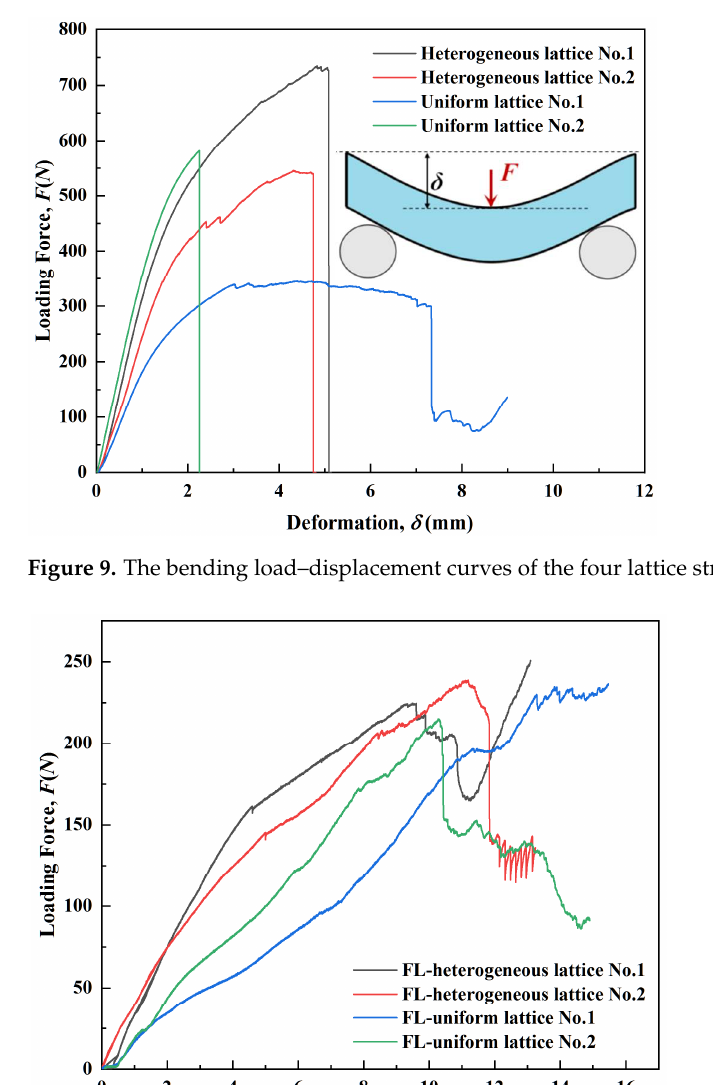
Figure 8. The weight of the eight types of lattice samples compared to their CAD models.